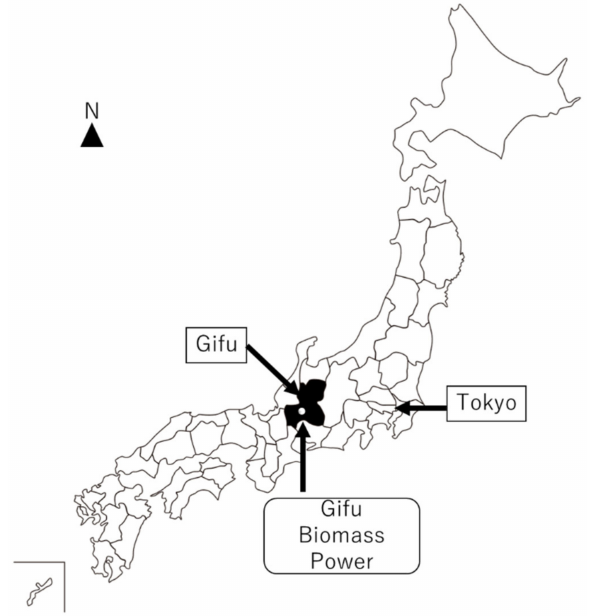
Figure 1. Map of Gifu Biomass Power Co., Ltd.; Gifu Prefecture, where Gifu Biomass Power Co., Ltd. Is located, is in the center of